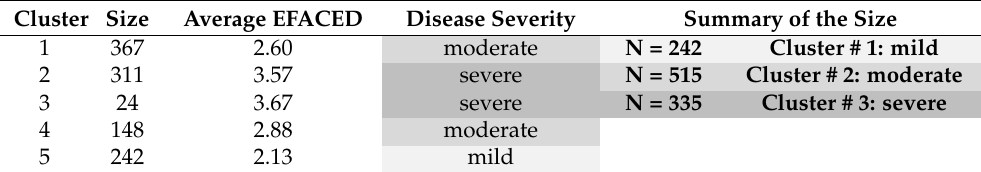
Table 1. Characteristics of the five clusters resulting from the hierarchical clustering